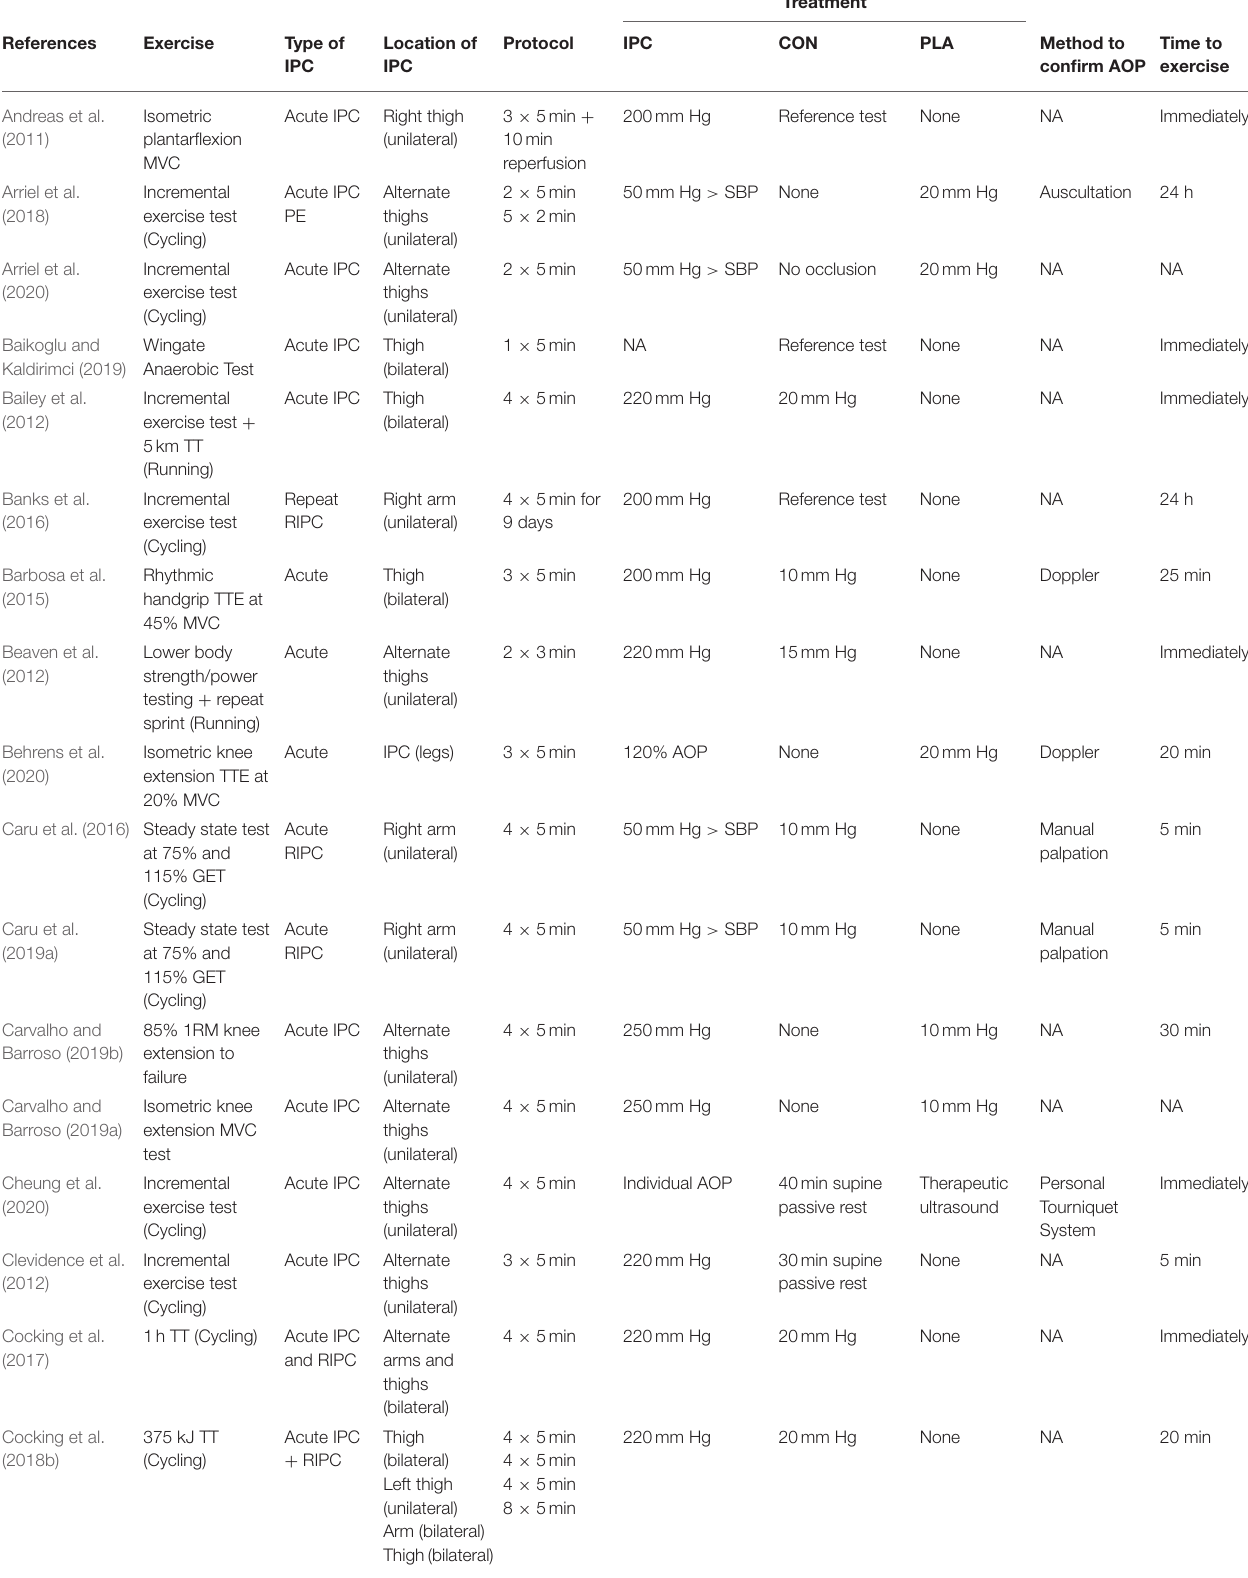
TABLE 1 | Methodological summary of studies examining IPC on exercise performance